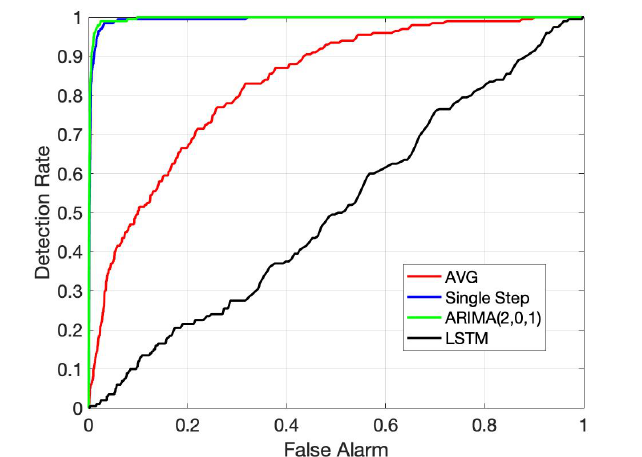
Figure 7. ROC for the generated test cases with slight